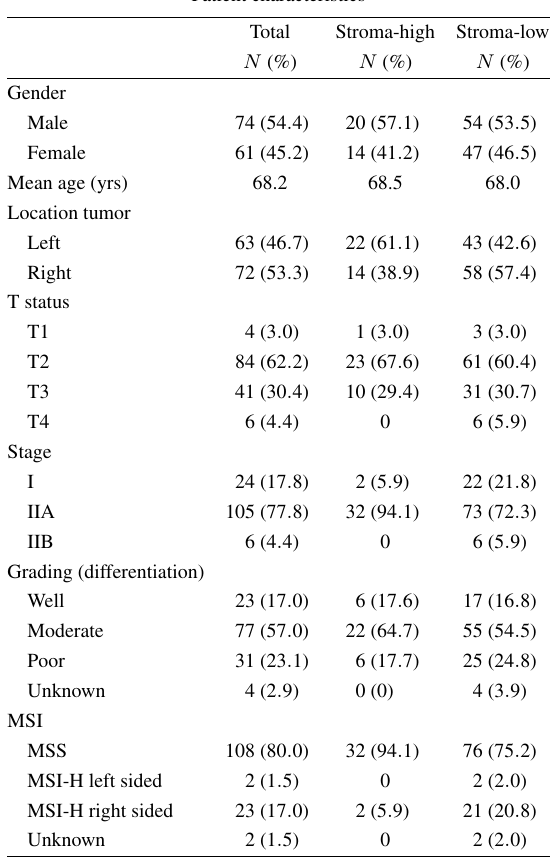
(Table 2, Suppl. Table 1: